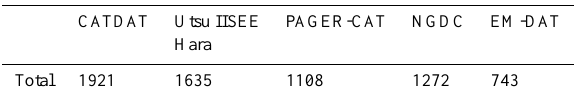
Table 3. The number of fatal earthquakes from 1900–June 2008 as shown in earthquake databases (without removal of error earth- quakes in these